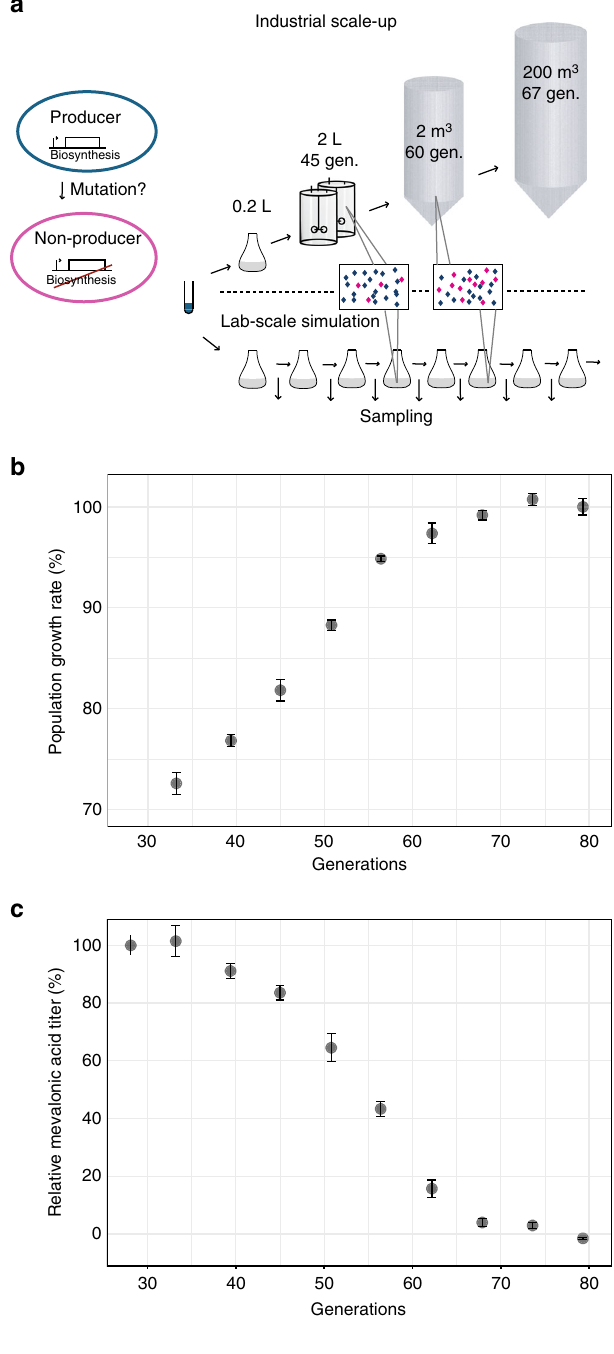
Fig. 1 Stability of the mevalonic acid-producing phenotype. a Large-scale industrial production of mevalonic acid was simulated through serial transfer of fi ve parallel mevalonic acid-producing populations. The length of the fermentation simulation was chosen to mimic the generation number of a fermentation population in a 200 m 3 fermentation tank. Production populations were sampled every 8 h for subsequent phenotypic and genotypic analysis (Supplementary Table 2). b Population-level average local growth rates were determined for parallel populations over the course of the experiment (Methods). The means are shown relative to the last time point (absolute value 0.84/h). A transition of the mean population growth rate is observed after 35 generations, in which the population growth rate increases to a stable phenotypic state after 70 generations, alleviating the measured production load (Supplementary Fig. 1). c Mevalonic acid titers during the simulated fermentations. The means are shown relative to the earliest time point (Supplementary Table 3) and were calculated from fi ve parallel lineages of the E . coli TOP10 mevalonic acid- producing clone. Error bars denote s.e.m. ( n =